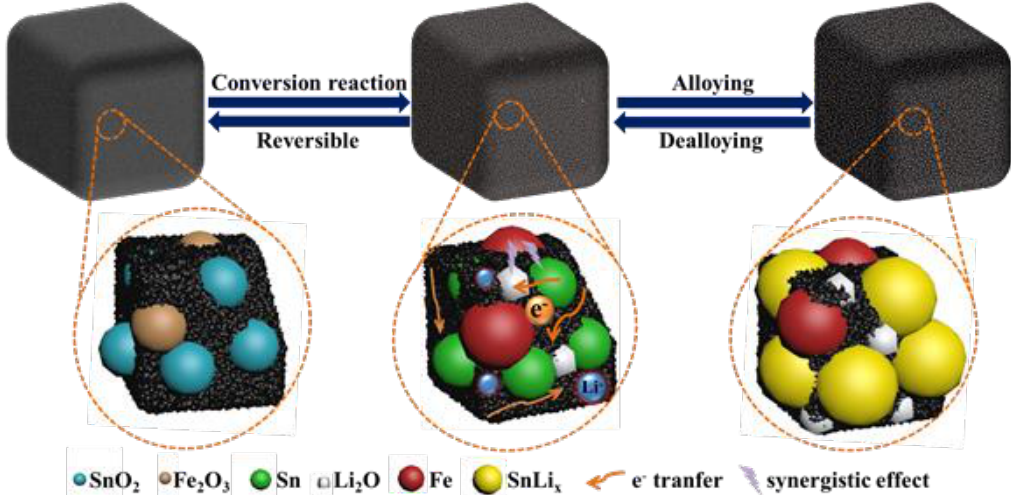
Figure 7. Schematic diagram of SFO@C as anode materials during cycling. 660